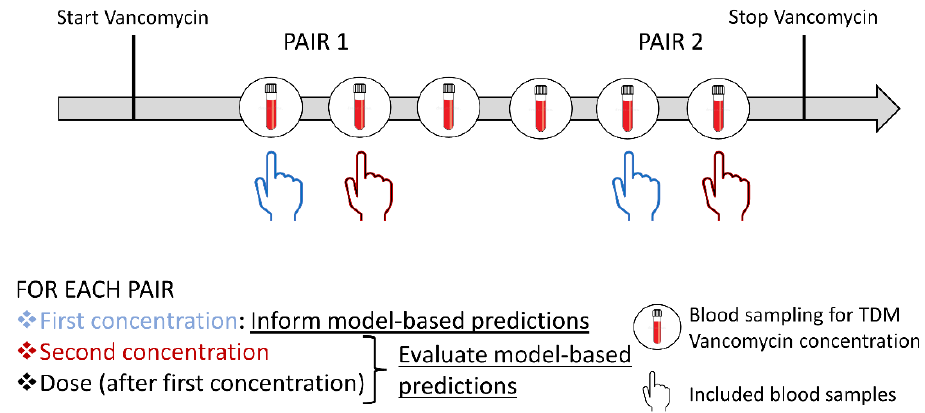
Figure 1. Schematic representation of the inclusion of two pairs of two consecutive vancomycin concentrations using a random example as illustration. The first concentration of each pair was used to inform the model-based predictions. The second concentration was blinded from the models and was used to evaluate the performance of the model-based prediction. The model-predicted dose after the first concentration was used to evaluate the model-based doses compared with the standard TDM-based doses.